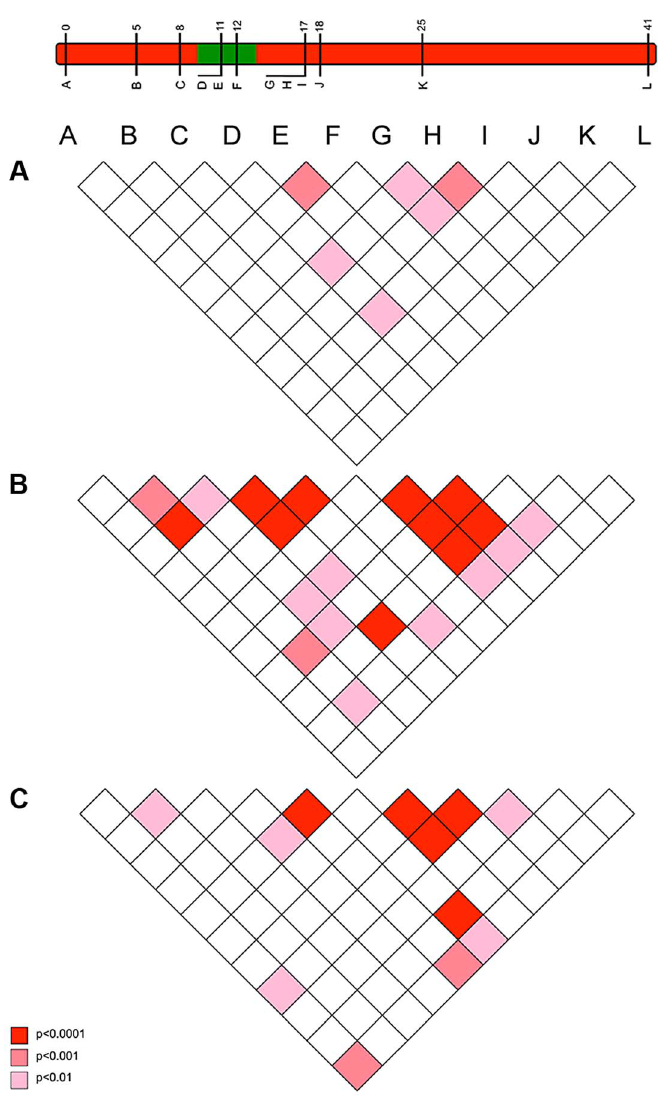
Figure 5. The pattern of linkage disequilibrium (association) between loci observed in 2001 (pre-sweep), 2006 (immediately post- sweep) & 2010 (4 years post sweep) population samples. Pattern of linkage disequilibrium (LD) between suppressor-linked loci (A-L) for a) 2001 (pre-sweep), b) 2006 (immediately post-sweep), and c) 2010 (4 years post-sweep). Significance denoted by colour: deep red – significant LD as measured at p , 0.001; mid red – significant LD as measured at p , 0.01; pink – significant LD as measured at p , 0.05, all uncorrected for multiple tests. Depiction of suppressor linkage group given for reference.